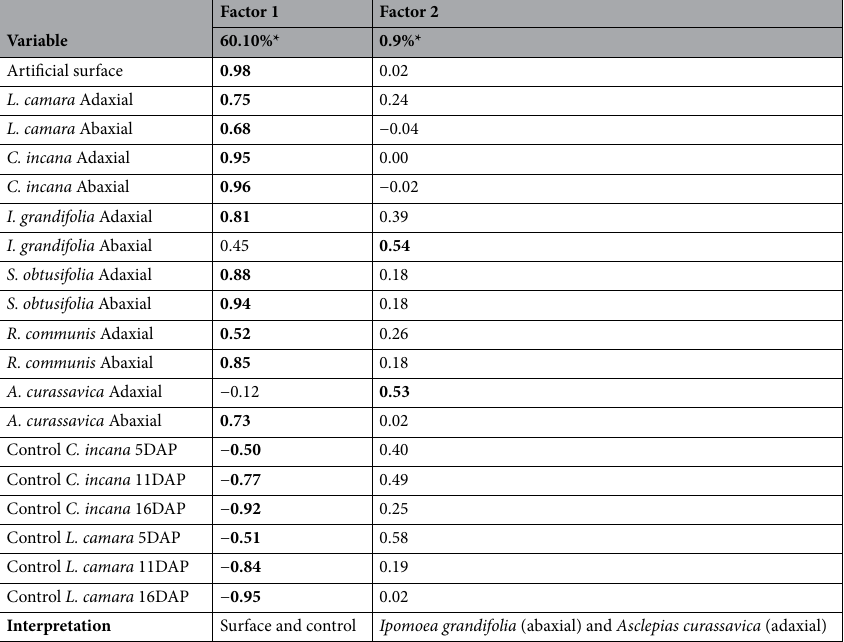
Table 1. Result of the analysis of factors containing the first two factors (processes) with their respective factorial loads that represent the correlation coefficients between the foliar surfaces and control and each Factor. *Value relative to the percentage of variation of the original set of data retained by the respective factors. Load values in bold (> 0.50 in absolute value) were considered in the interpretation of the factor. Artificial surface = Parafilm; DAP = Days after